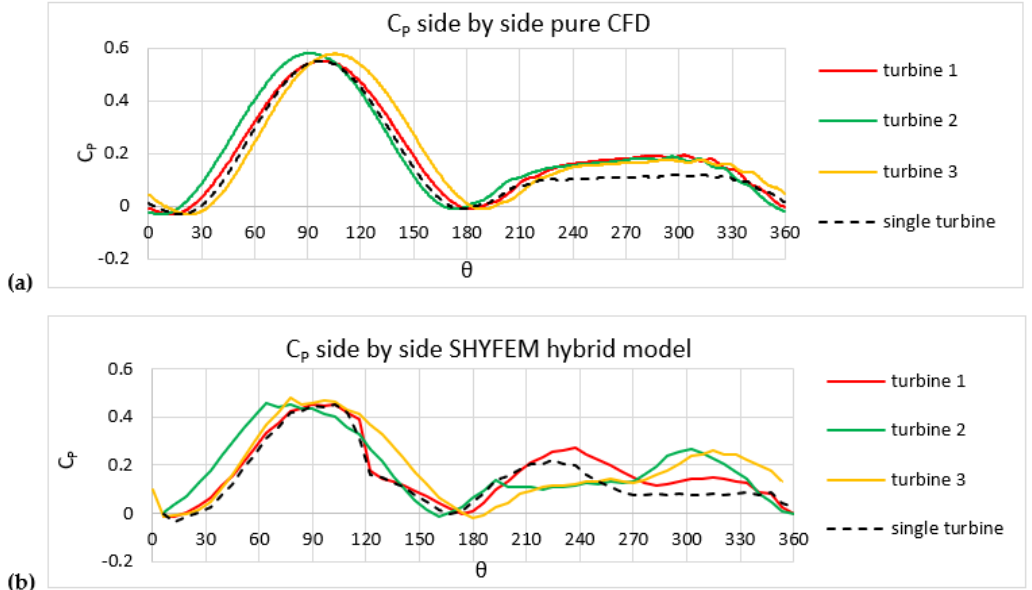
Figure 17. C P for the side-by-side triad both for the pure CFD ( a ) and SHYFEM hybrid model ( b ).